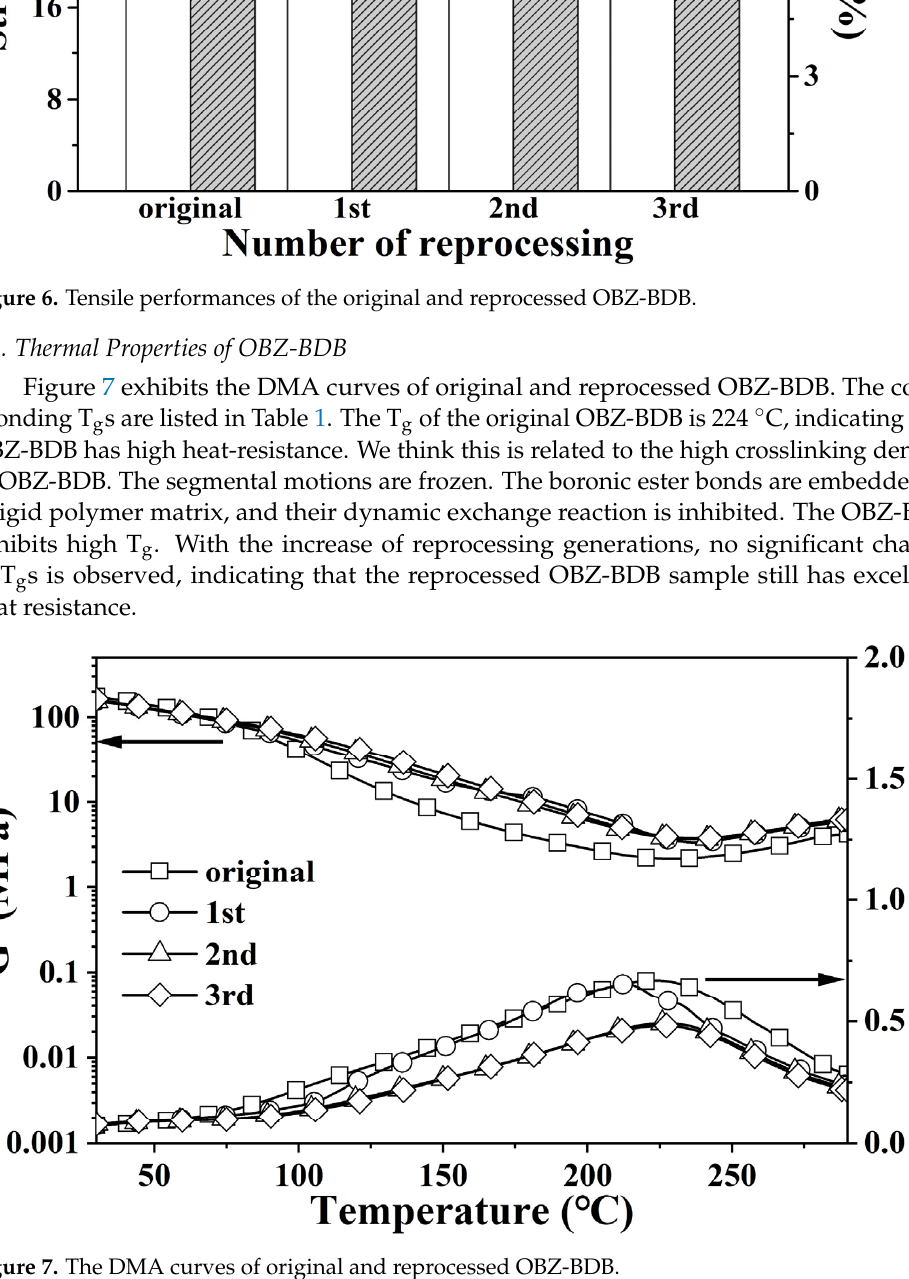
Figure 7. The DMA curves of original and reprocessed OBZ-BDB.